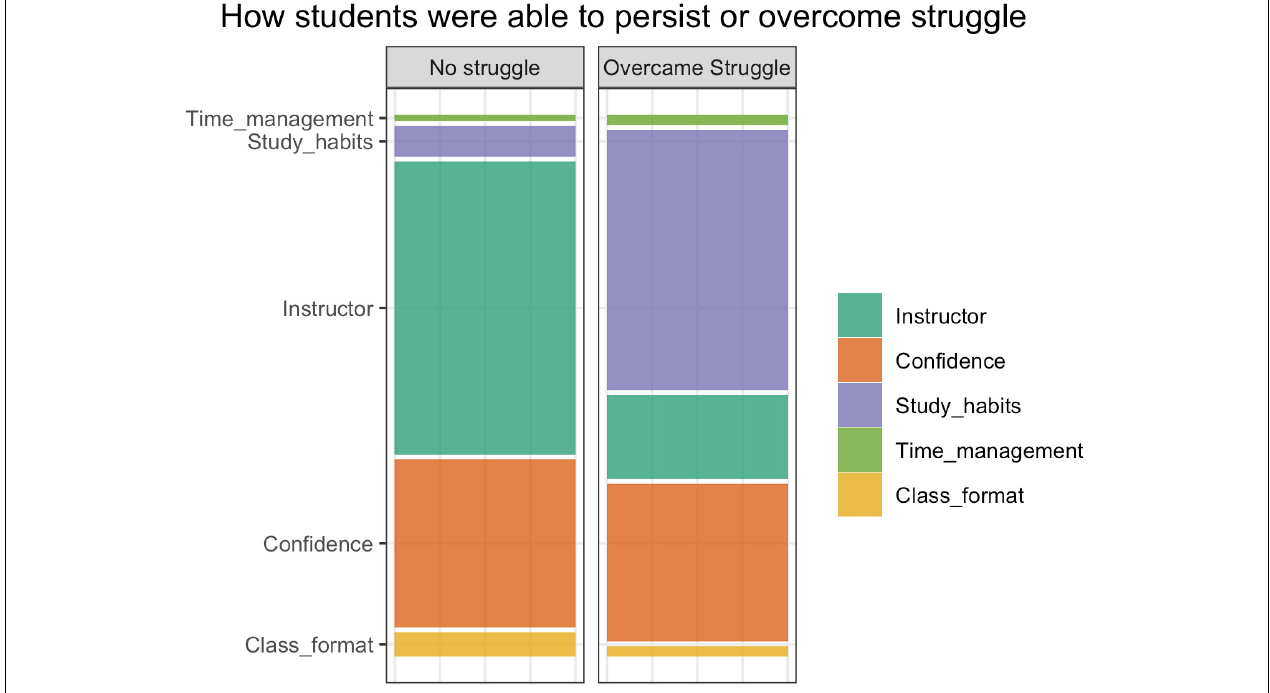
FIGURE 3 | Mosaic plots depicting qualitative responses of how students were able to persist above the challenges of the Spring 2021 semester (No struggle) or students that were able to persevere and overcome their struggles (Overcame struggle). See Table 4 for percentages in each